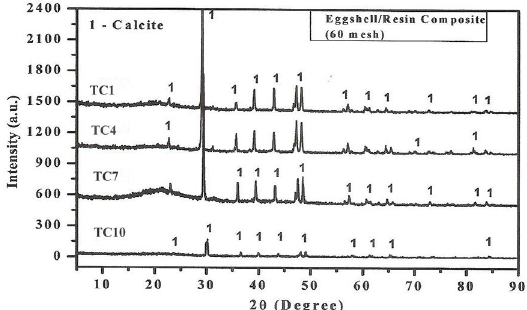
Figure 2. X-ray diffraction pattern of the artificial rocks produced with chicken eggshell waste (< 60 mesh).